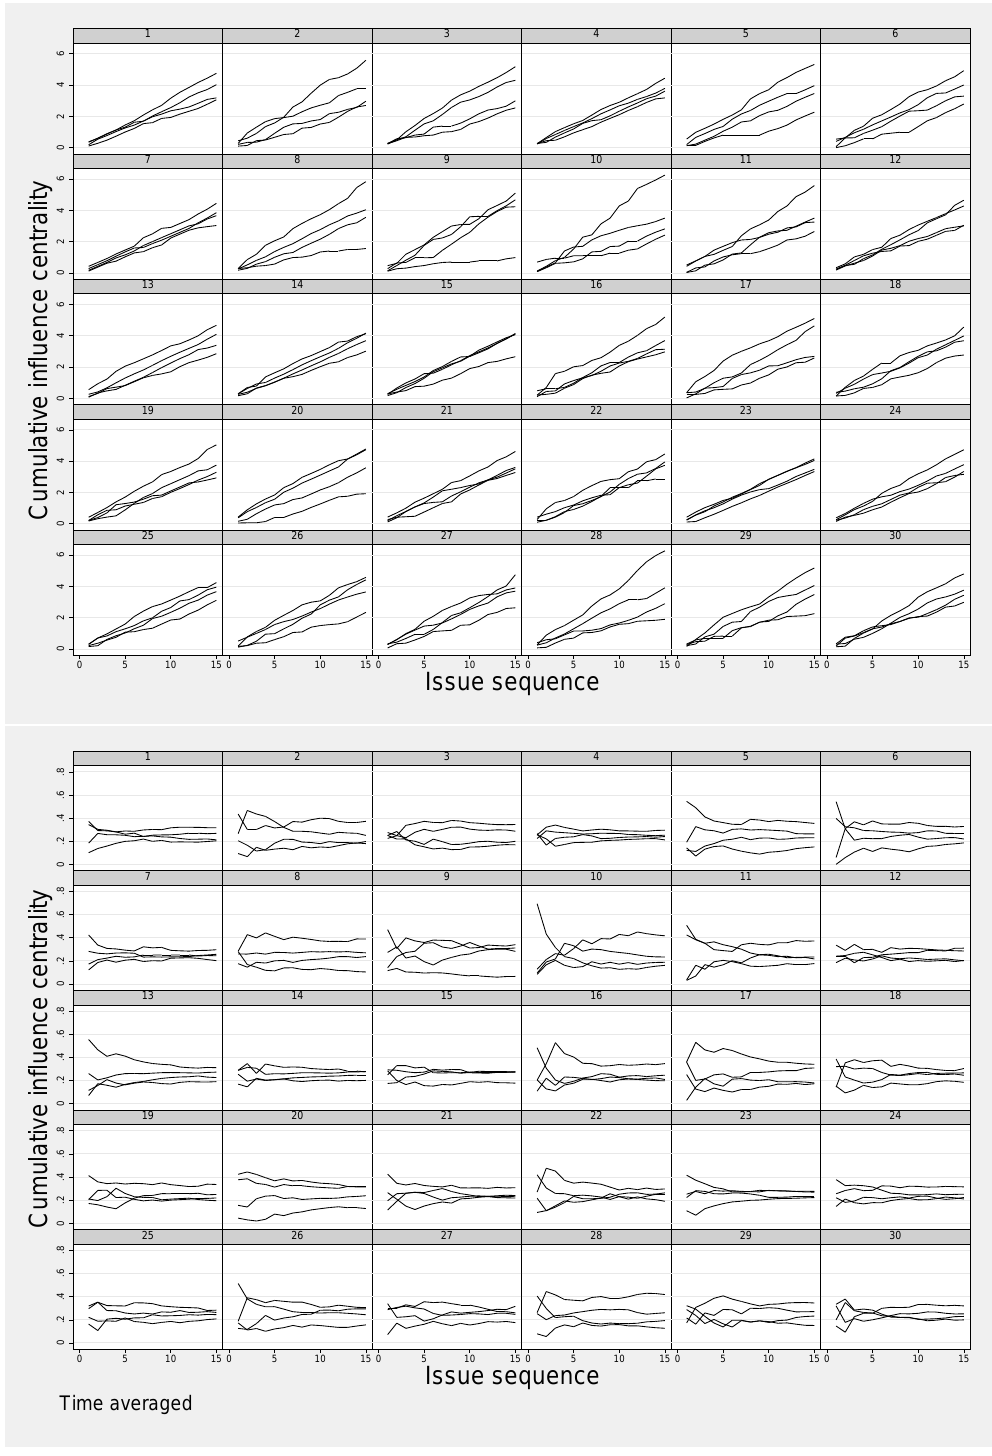
Figure 5: Evolution of individuals’ cumulative influence centrality ∑ s ∑ s T i ( s ) = 1 C i ( t ) for each individual in each of the 30 groups along the issue sequence. t = 1 s